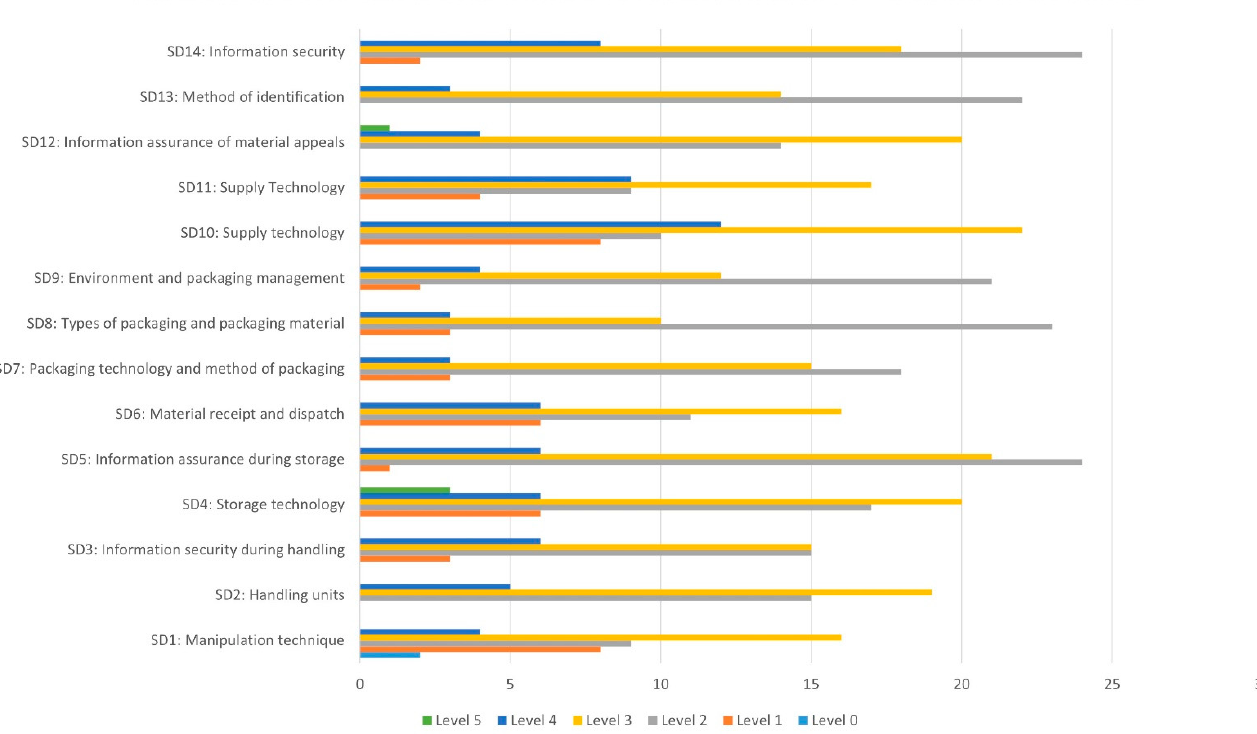
Figure 9. Number of level value occurrences for subdimensions—automotive sector .